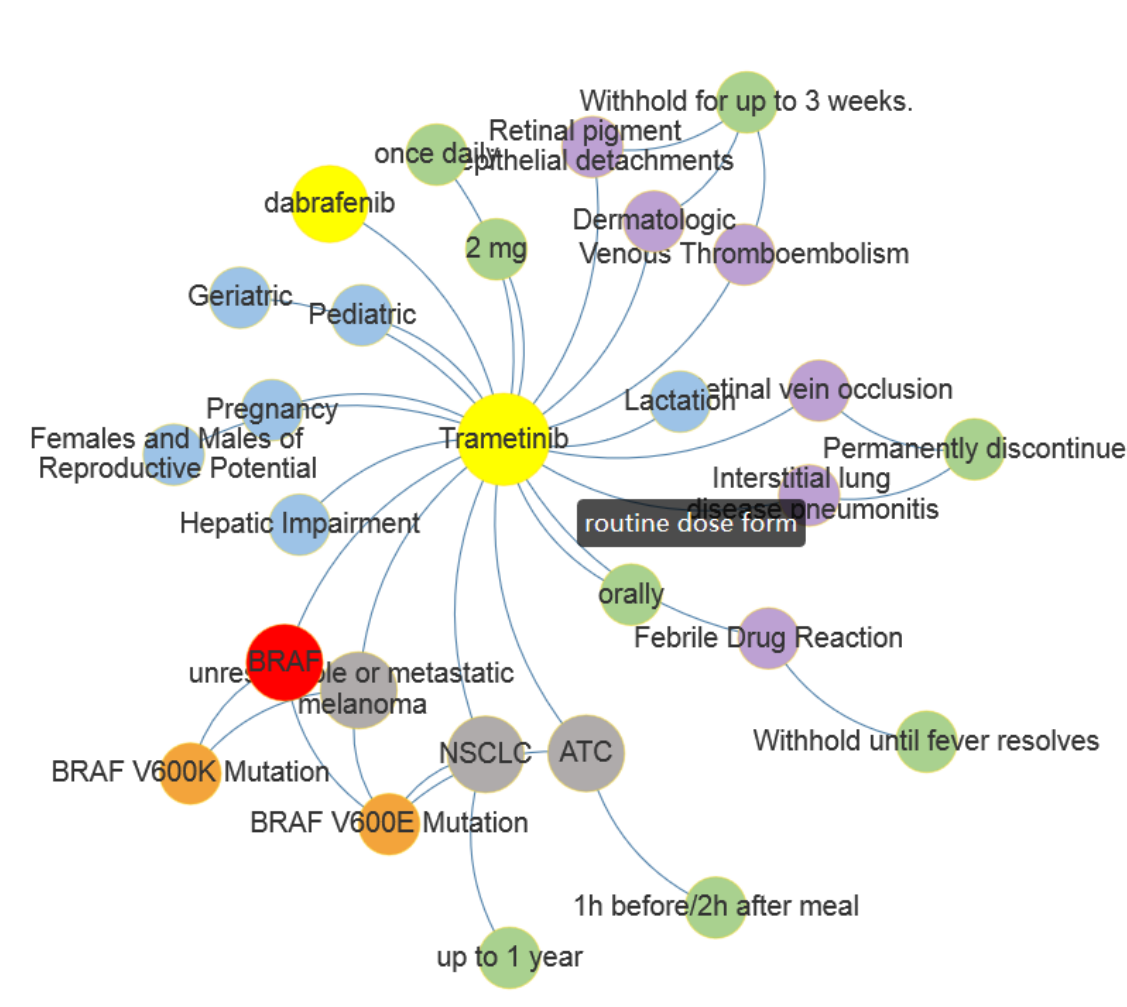
Figure 6. An example of pharmacogenomics knowledge model data